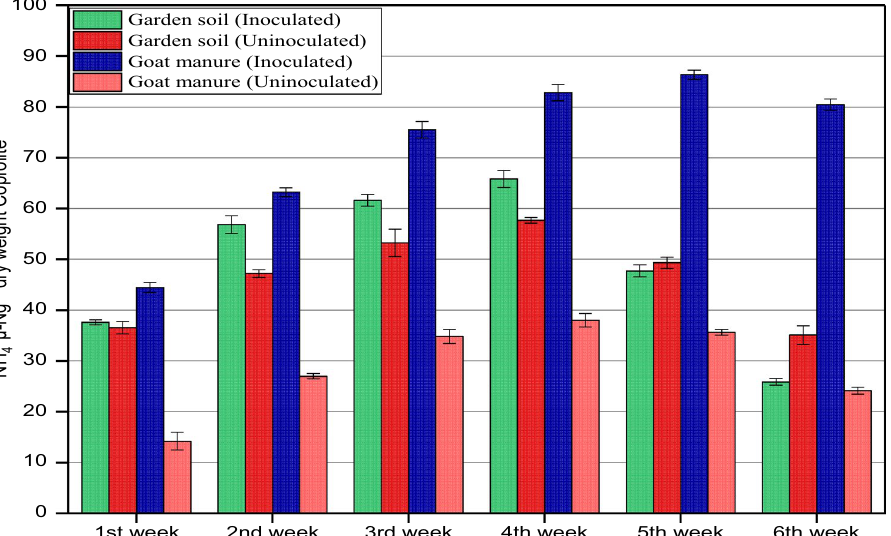
Figure 1. NH 4 + content in coprolites with and without A. caliginosa from garden soil (GS) and goat manure (GM) at different intervals of the experiment.